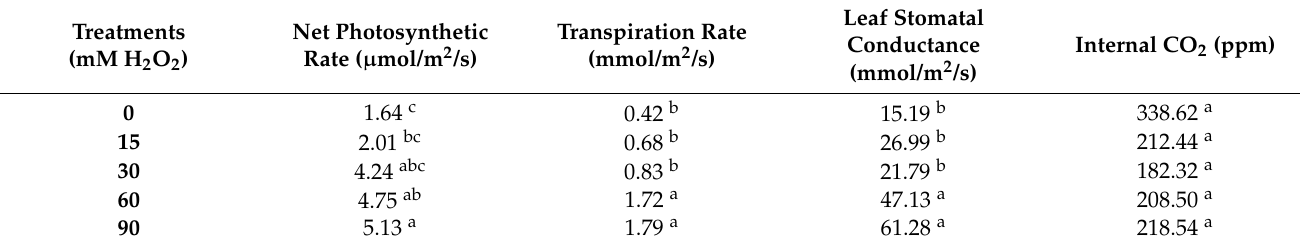
Table 1. Effects of different treatments of H 2 O 2 on net photosynthetic rate, transpiration rate, leaf stomatal conductance, and internal CO 2 of F. deltoidea